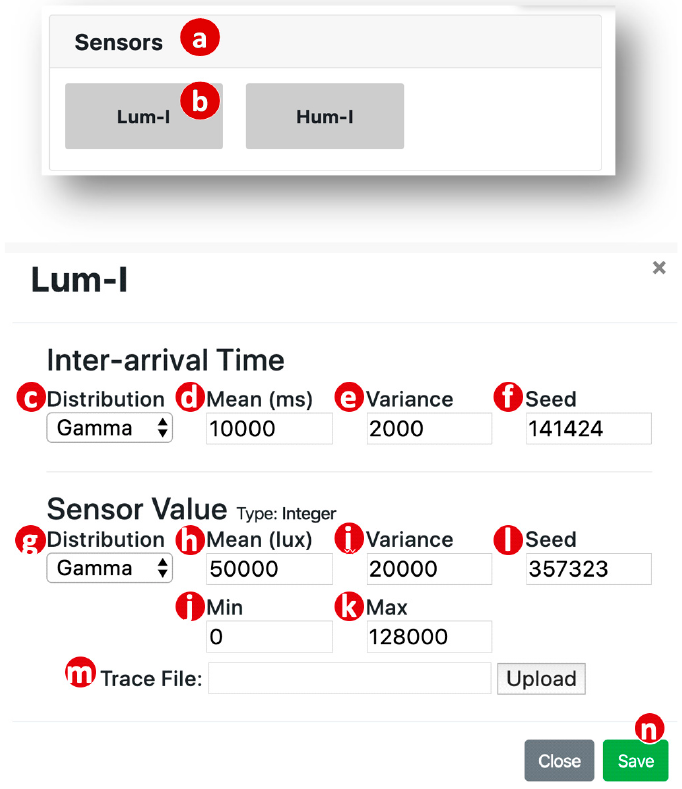
Figure 5. Web-based SimTalk graphical user interface (GUI).